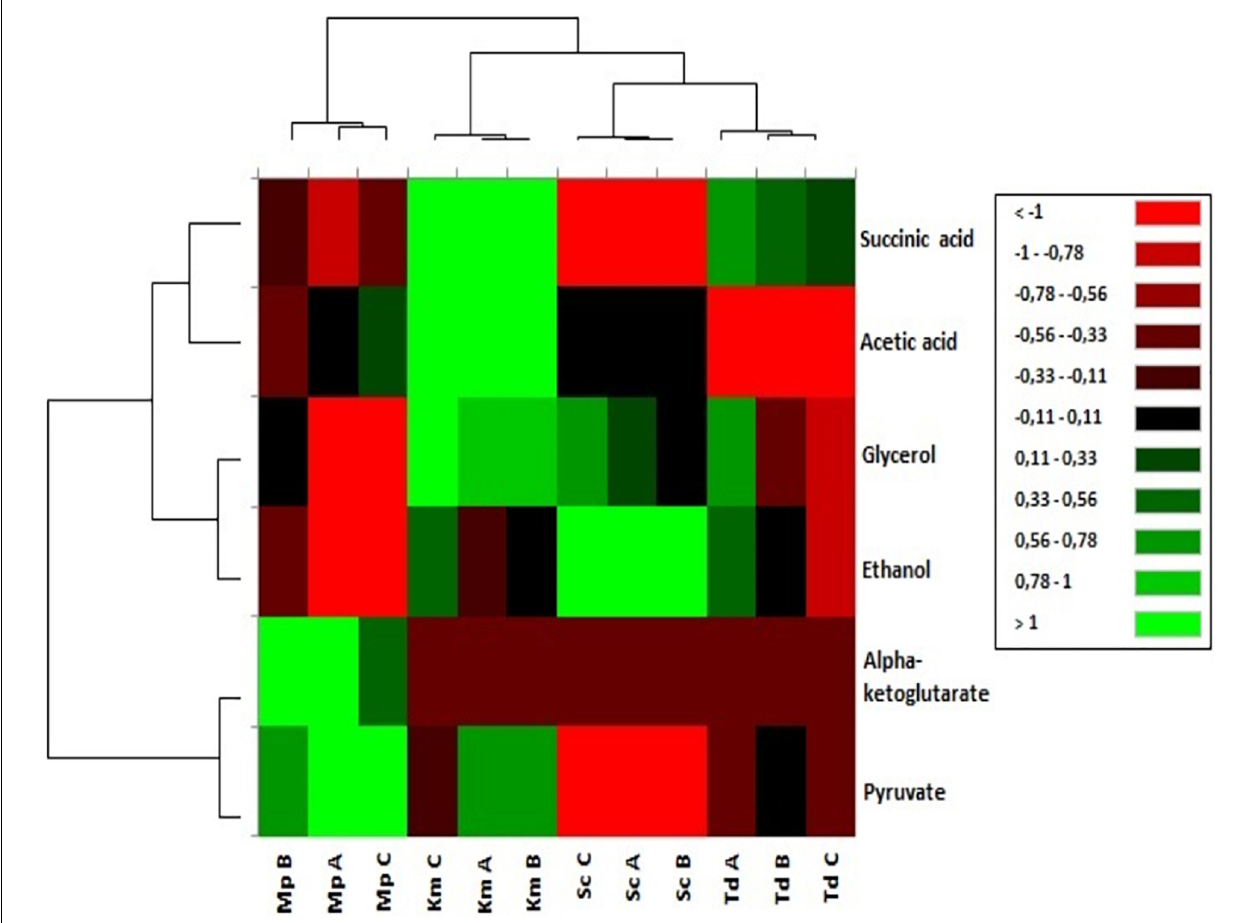
FIGURE 4 | Hierarchical cluster analysis of fermentation derived metabolites yields (mM/M sugar consumed) grouped based on chemical properties and yeasts.